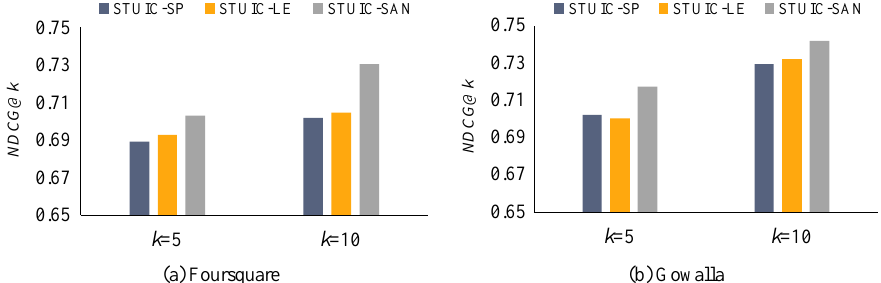
Figure 9. Effect of different spatio-temporal interval correlation processing on recommendation